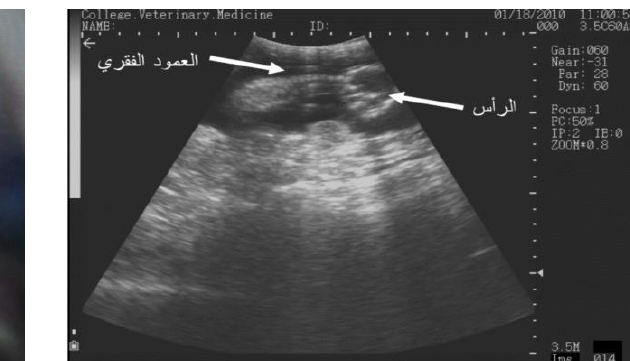
Figure, 7: laparoscopical diagnosis of ovary contained large C.L.